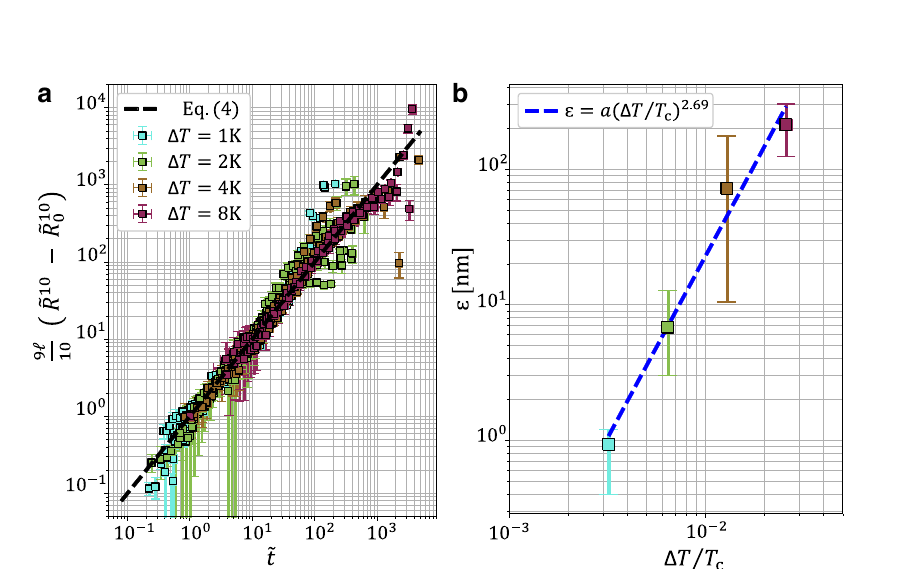
as indicated. The dashed lines indicate the predictions of Eq. (2), using the ℓ values obtained from the fi ts in a . Error bars on rescaled radius and contact angle are obtained using the errors on droplet height and contact radius described in Sup- plementary Method 2. Source data are provided as a Source Data fi